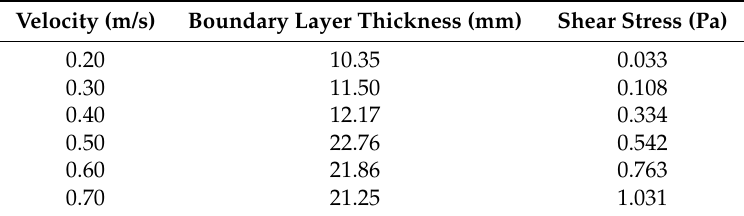
Figure 10. ( a ) Velocity profiles obtained by Laser Doppler Velocimetry (LDV) compares with laminar Blasius velocity profile. ( b ) Velocity profiles obtained by LDV compares with turbulent Spalding velocity profile. ( c ) Boundary layer thickness calculated by velocity profiles compared with laminar and turbulence empirical formulas values. Table 4. Boundary layer thickness and shear stress measured by LDV.